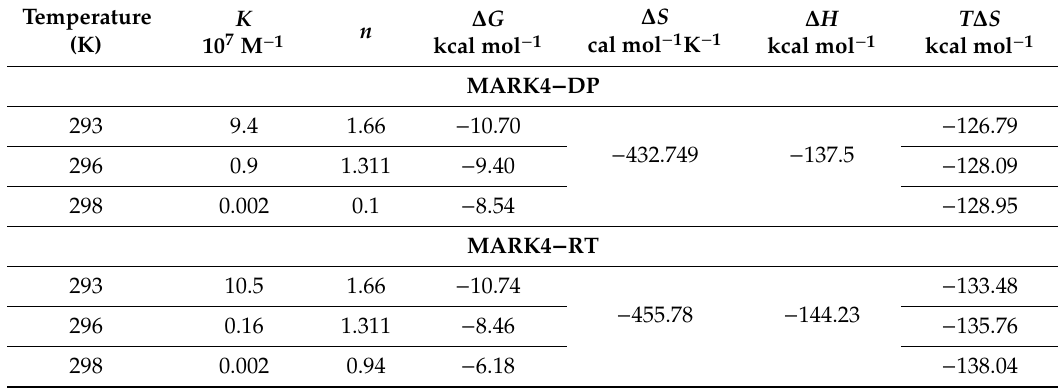
Table 2. Thermodynamic parameters obtained from fluorescence quenching studies carried out at di ff erent temperatures.